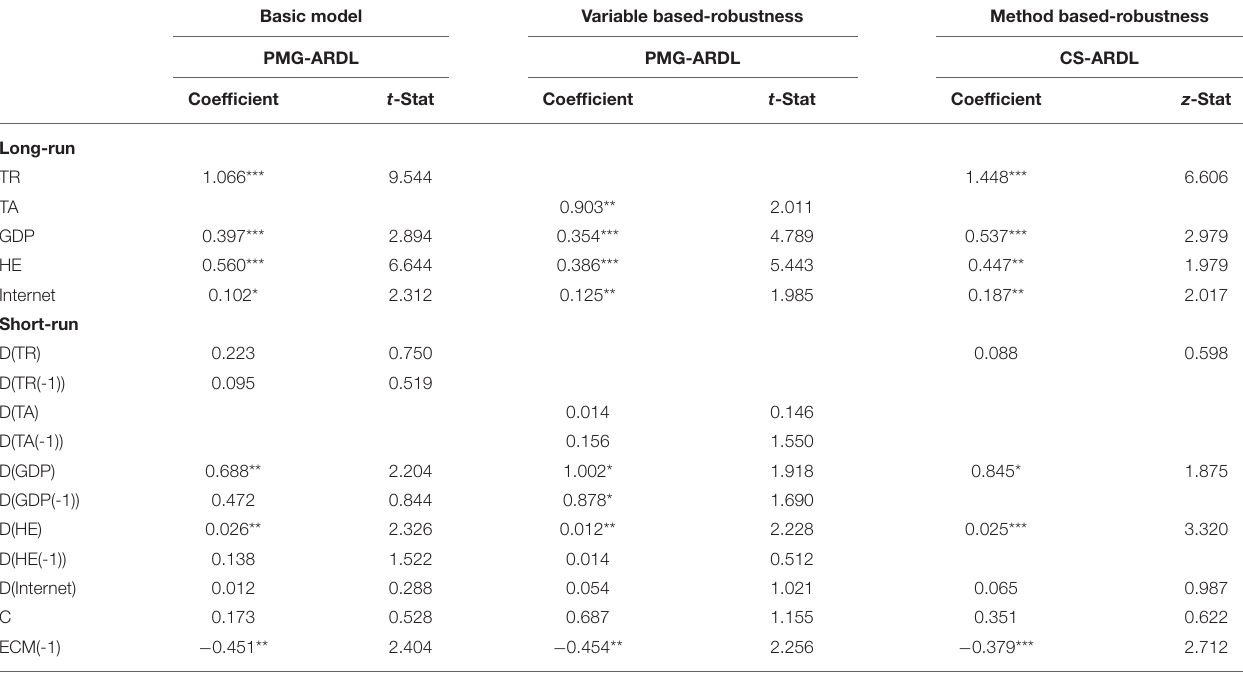
TABLE 4 | Long and short-run estimates of human